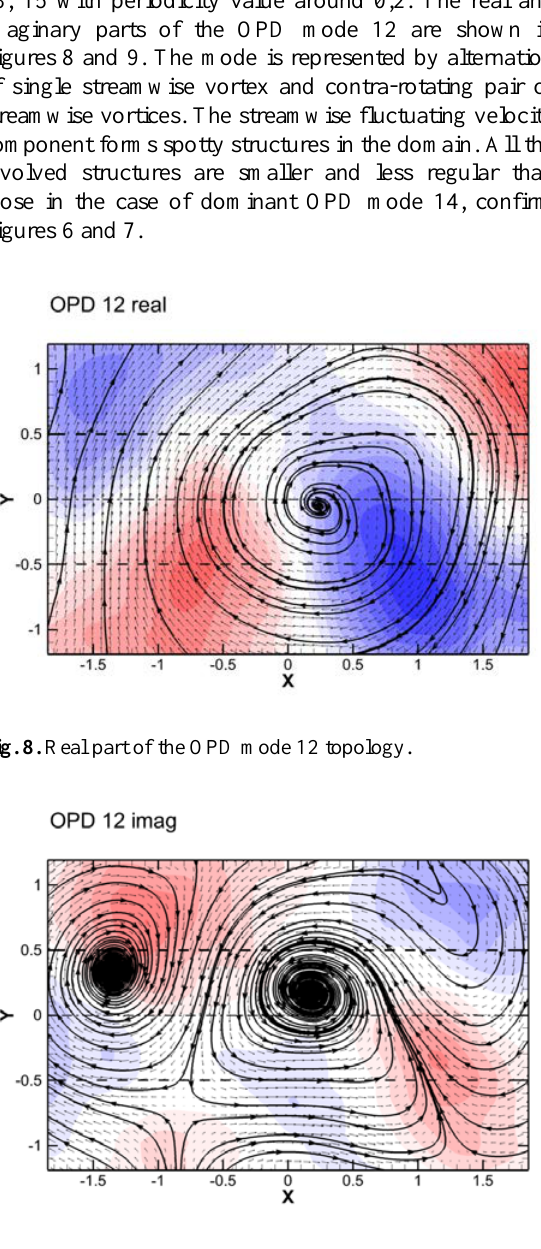
Fig. 9. Imaginary part of the OPD mode 12 topology